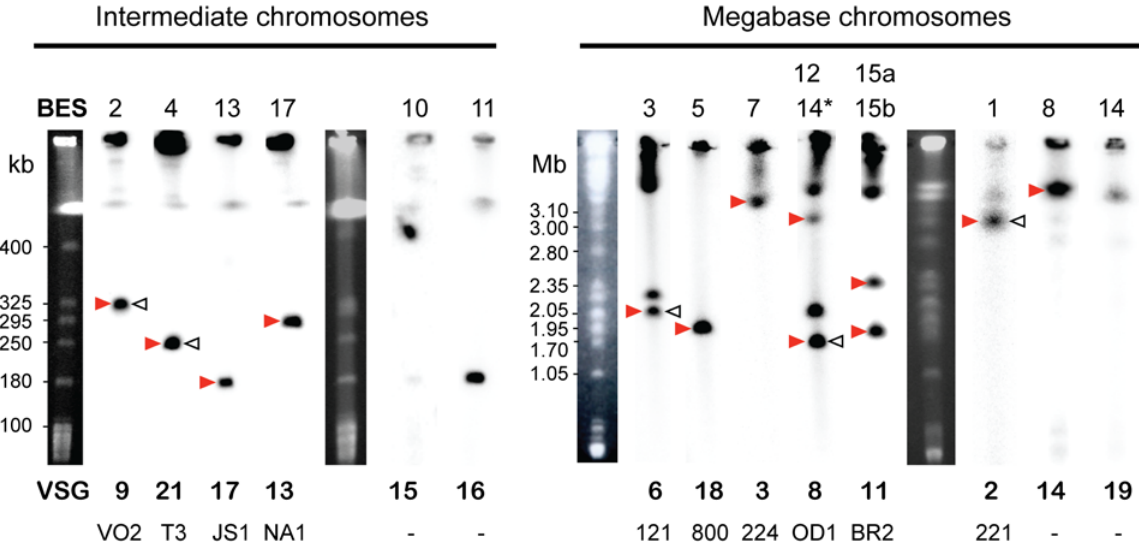
Figure 1. Chromosomal distribution of BES-resident VSG s. Red arrows indicate BES randomly tagged in this study with NEO . Open arrows indicate BES activated by [58] and subsequently tagged. Names of VSG genes are indicated at the bottom, using the newly proposed strain-specific numbering (top row) and lab-specific names (bottom row). BES10 and 11 were not tagged in either study. BES14 is represented in two lanes: 14* refers to TAR117 (which was not sequenced and harbours VSG8), whereas 14 $ refers to TAR10 (which was sequenced and harbours